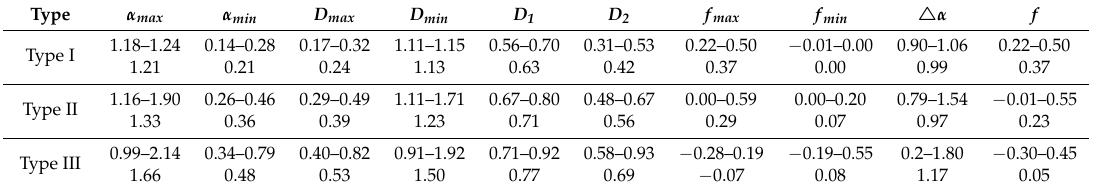
Table 4. Multifractal parameters of tight sandstone samples with different types of pore structure.